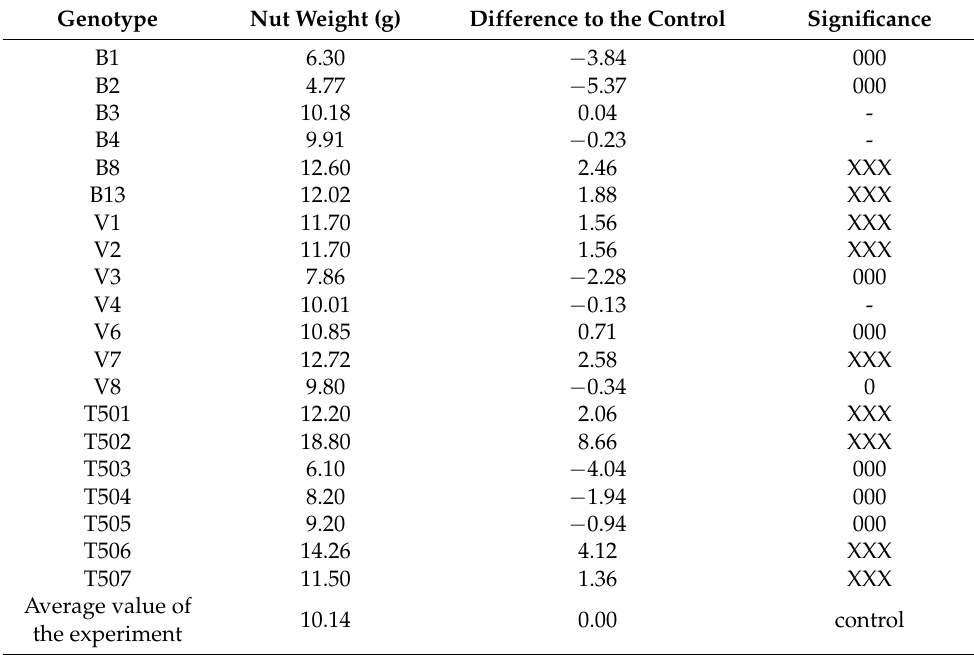
Table 1. Walnut weight of different genotype from west and north-west of